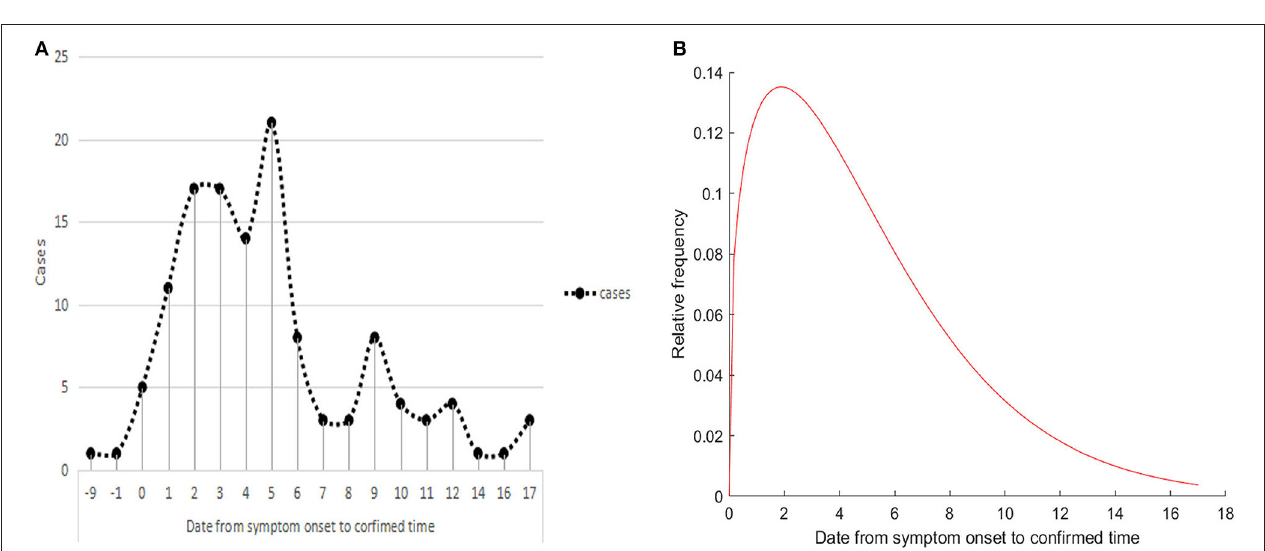
Frontiers in Medicine |